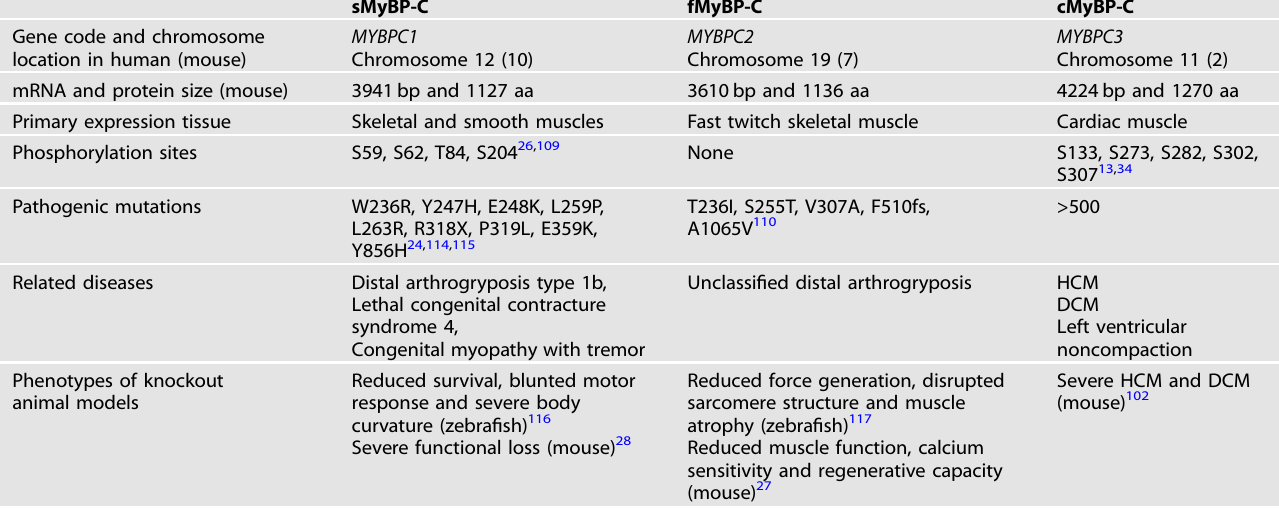
Table 1. Expression, modi fi cation and related diseases of three MyBP-C paralogs.